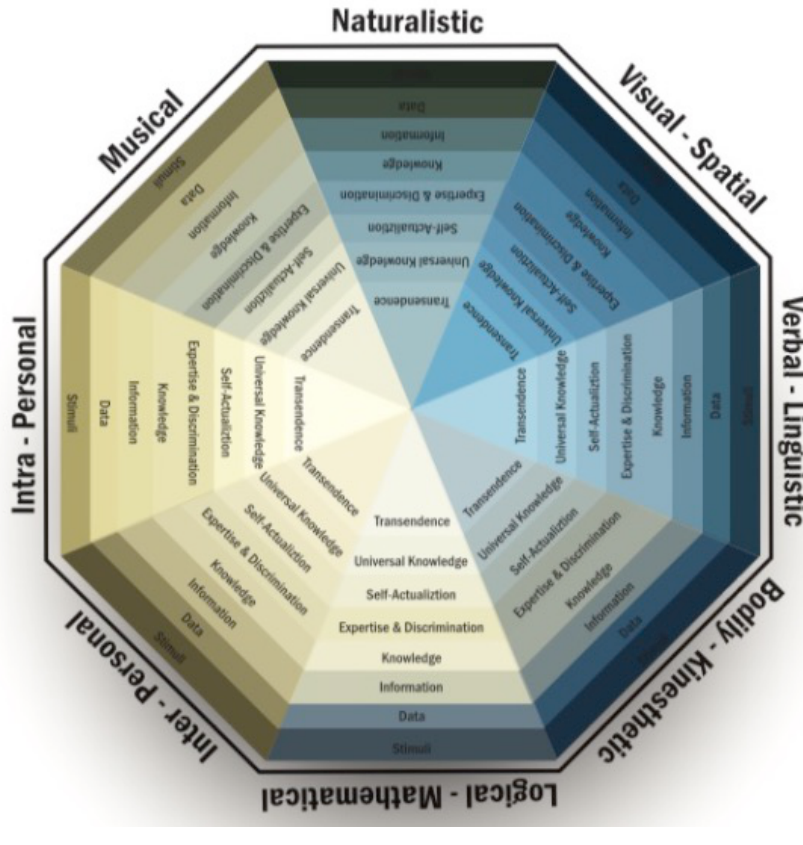
Fig. 8. The Consciousness-Intelligence-Knowledge